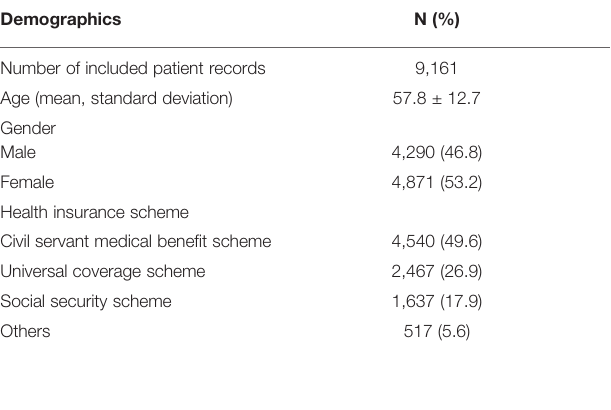
TABLE 1 | Baseline